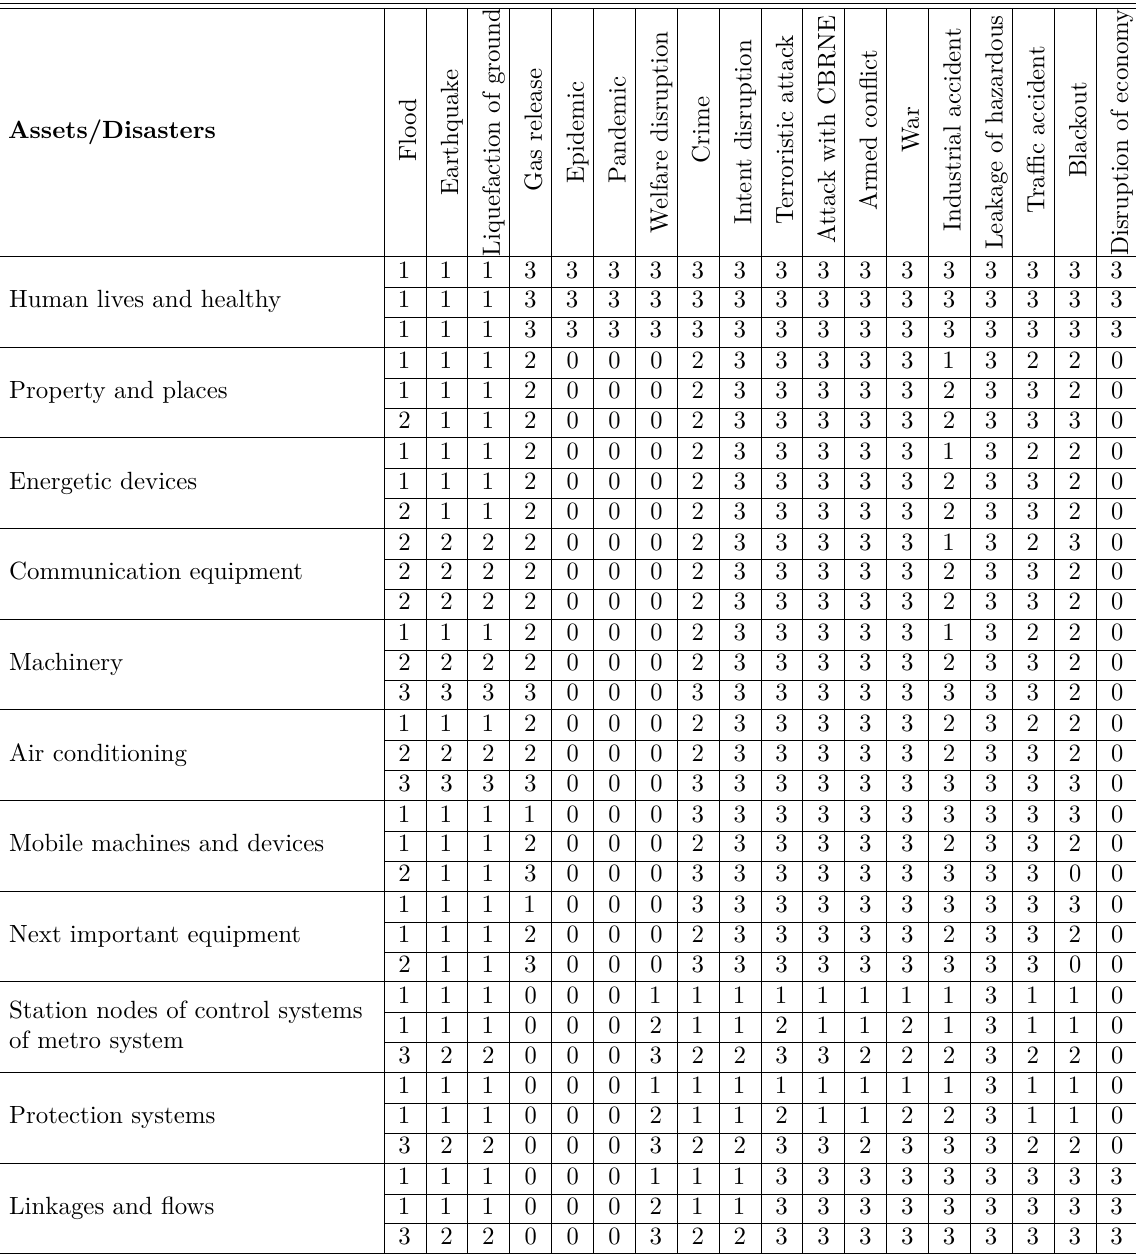
Table 3. Criticality of assets in metro